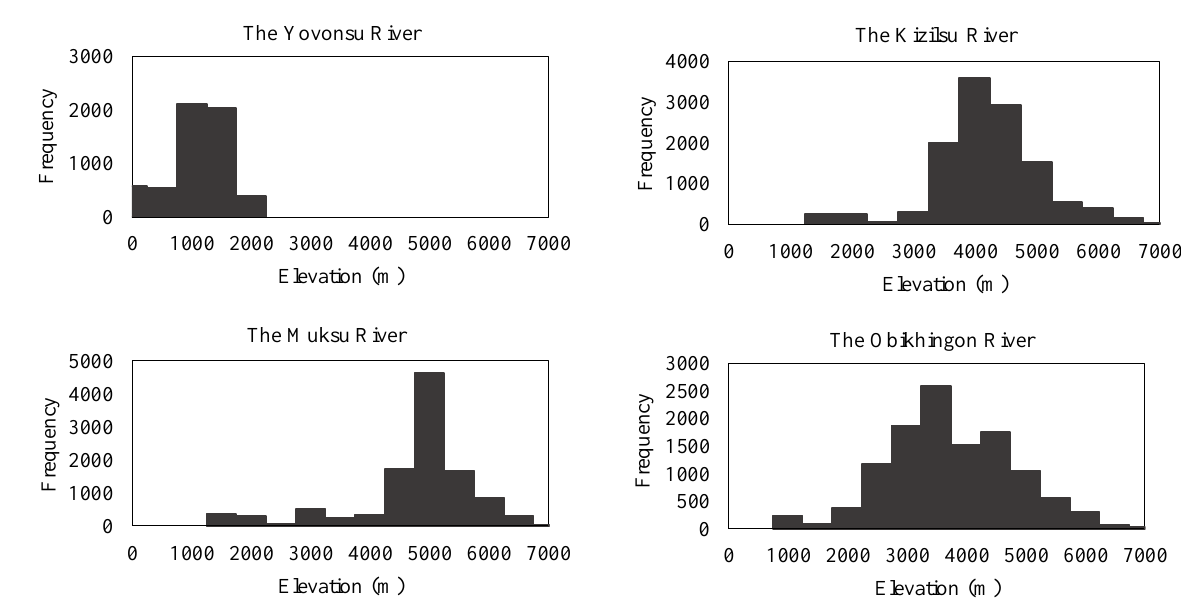
Figure 4. Elevation distribution histogram of the catchment boundary profile